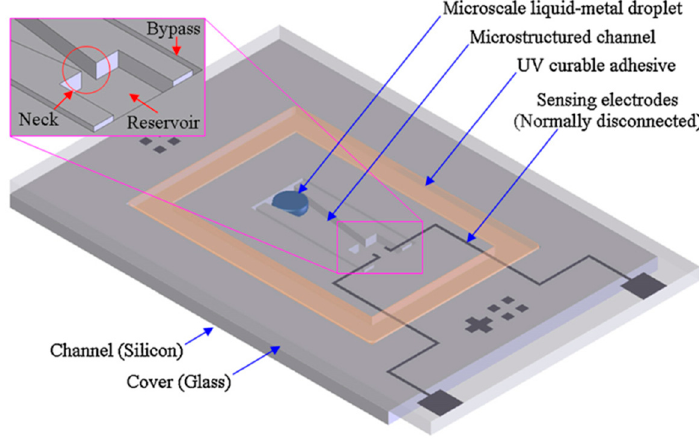
Figure 9. Scheme of a micro-fluidic switch [57].